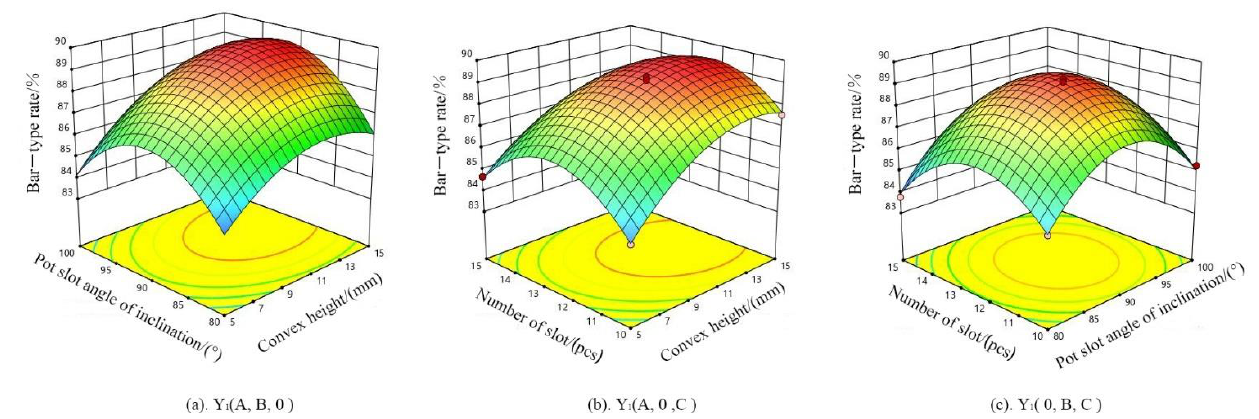
Figure 15. Response surface analysis of influencing factors of bar-type rate.